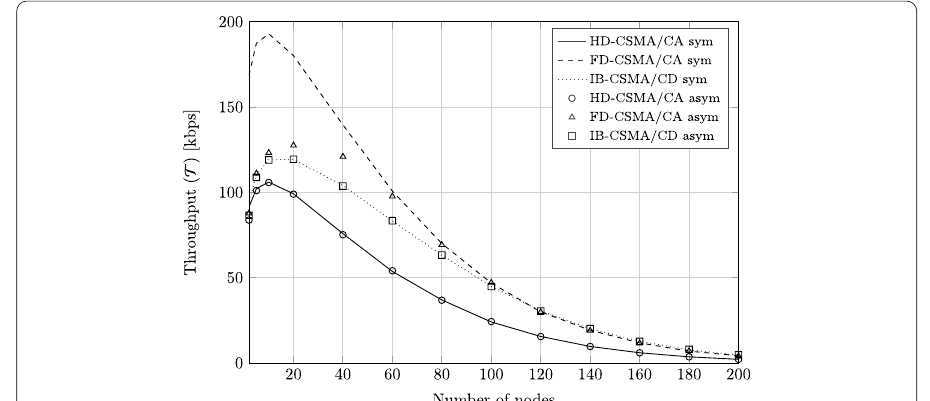
Fig. 8 Saturated scenarios (1 and 2): FD-CSMA/CA increases the throughput in saturated traffic conditions by 2 compared to HD-CSMA/CA. The increase of IB-CSMA/CD compared to HD-CSMA/CA is between 1.2 and